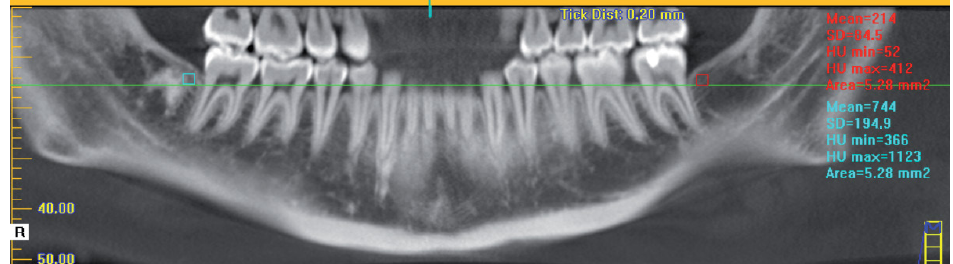
Figure 3- Measurement of bone density in the control and experimental groups